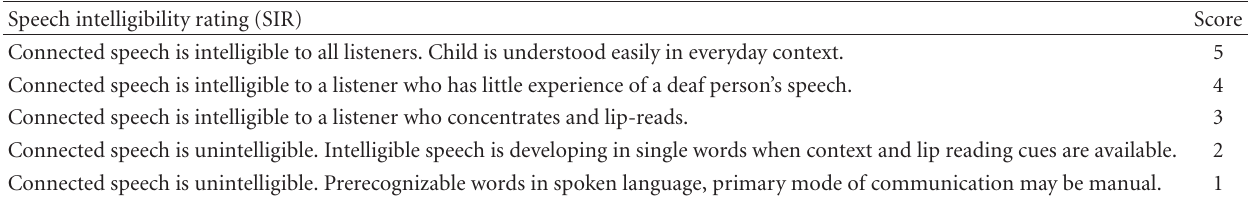
Table 3: Speech intelligibility rating (SIR) criteria.